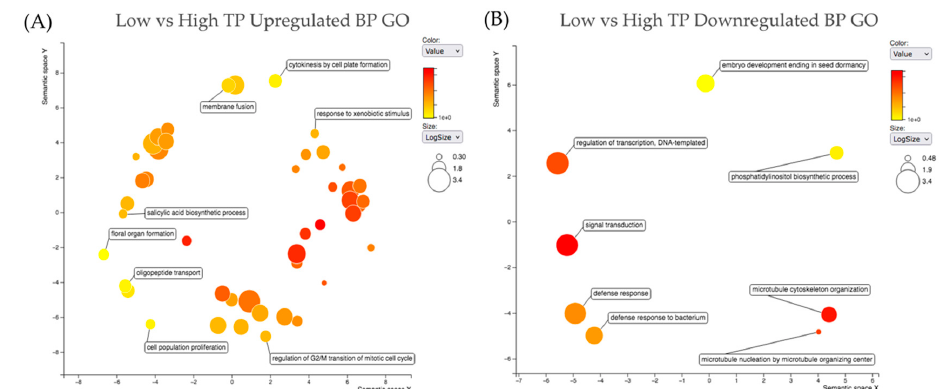
Figure 6. Revigo plots summarizing the relationships between the most indispensable biological process (BP) gene ontologies (GOs) for upregulated ( A ) and downregulated ( B ) shortlist genes across the high vs. low TP DE analyses. Circle size represents logSize value, higher logSize values indicate a strong presence of a term and/or its daughter terms; more general terms have larger bubbles. Color represents significance of a term among the query set of GOs.